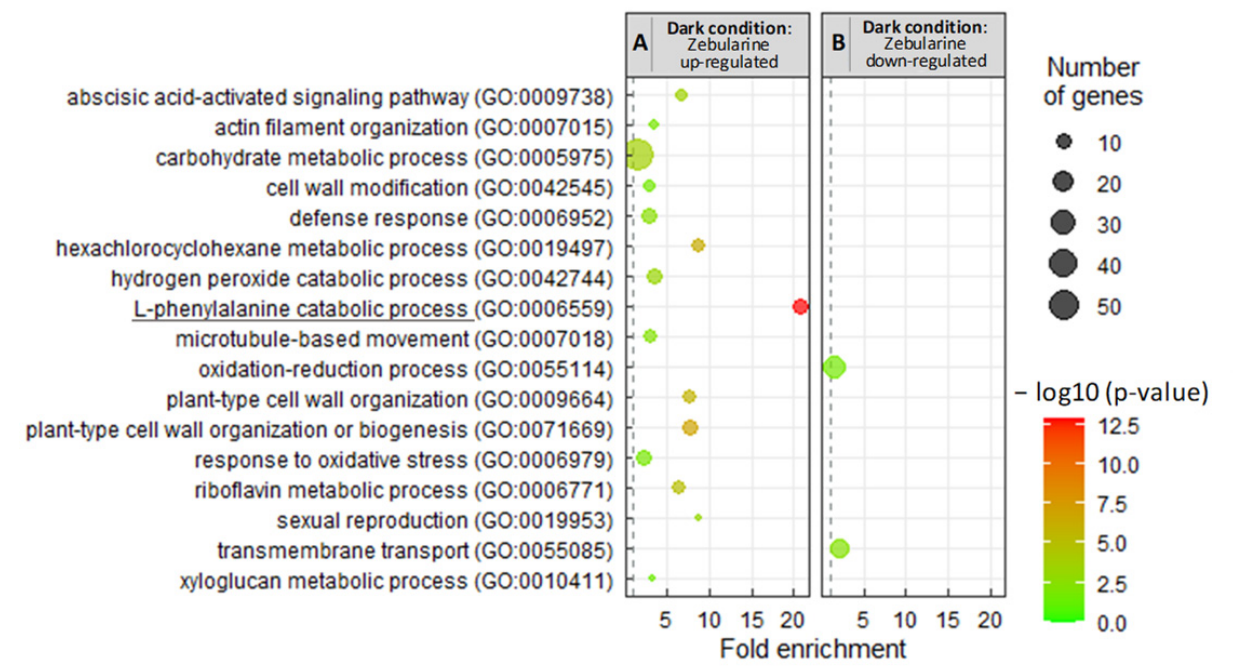
Figure 7. Analysis of the GO biological processes enrichment revealed few similarities between the genes which were deregulated by zebularine in the dark and in the light. The GO analysis (biological processes) was conducted for the genes which were up-regulated in the DZ50 samples compared to the DD samples ( A ) and down-regulated in the DZ50 samples compared to the DD samples ( B ). The common biological process between light- and dark- deregulated genes (comparison between Figures 6 and 7) is underlined.